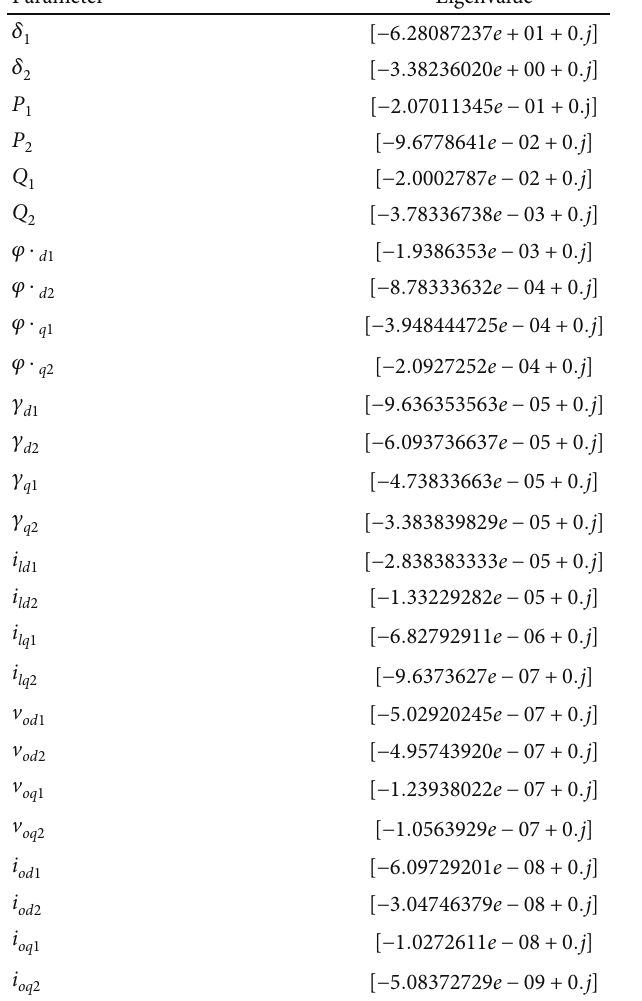
Table 3: State variables eigenvalues at an unstable state. Table 2: State variable eigenvalues at steady state.